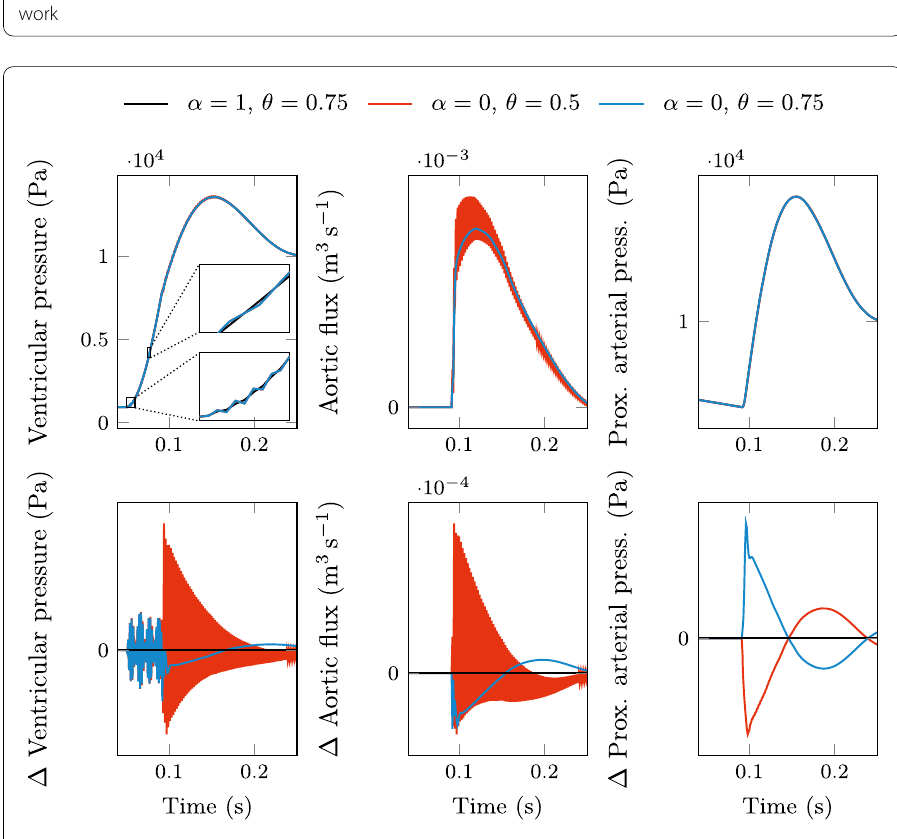
Fig. 7 Illustration of the ability of our numerical method to filter out spurious high-frequency modes. The upper plots correspond to the time evolution over a cardiac cycle of ( P n v , | P n v − P n ar | + / K ar ,P n ar ) for three different choices of parameters for the numerical viscosity. The lower plots show the time evolution of the difference with respect to a baseline case computed with ( α , θ ) = (1 , 0 .